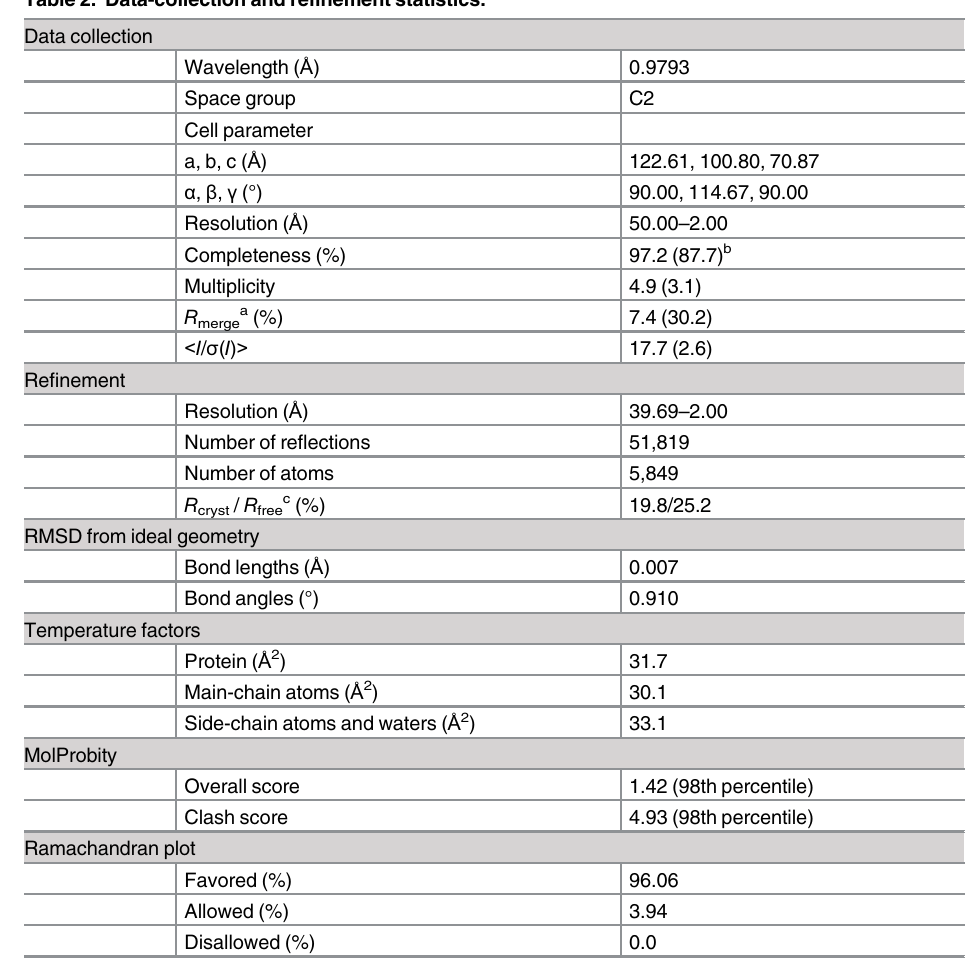
Table 2. Data-collection and refinement